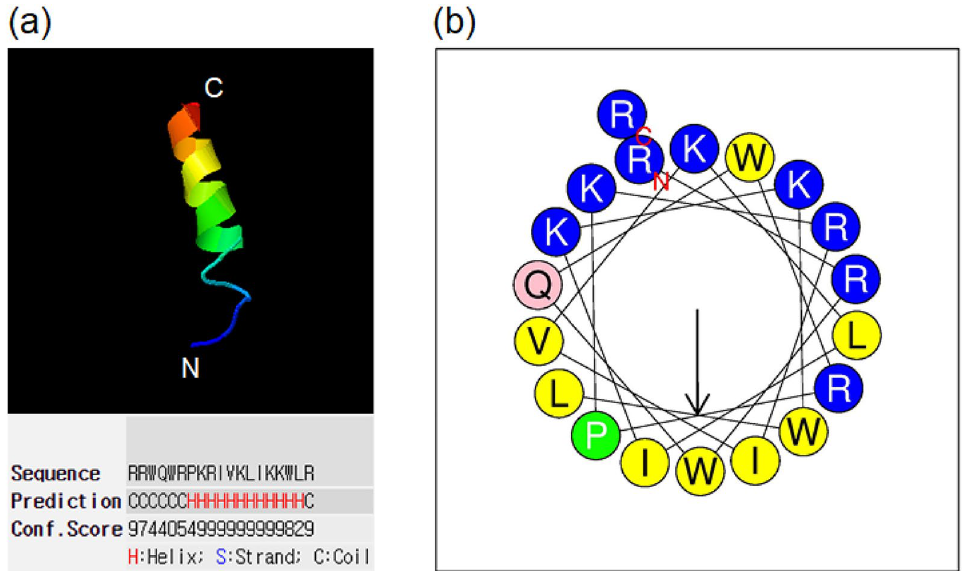
Figure 1. ( a ) Tertiary structure and ( b ) α-helical wheel plot of hybrid peptide Lf-KR predicted by automated I-TASSER server (http:// zhang lab. ccmb. med. umich. edu/I- TASSER/) and HeliQuest server (https:// heliq